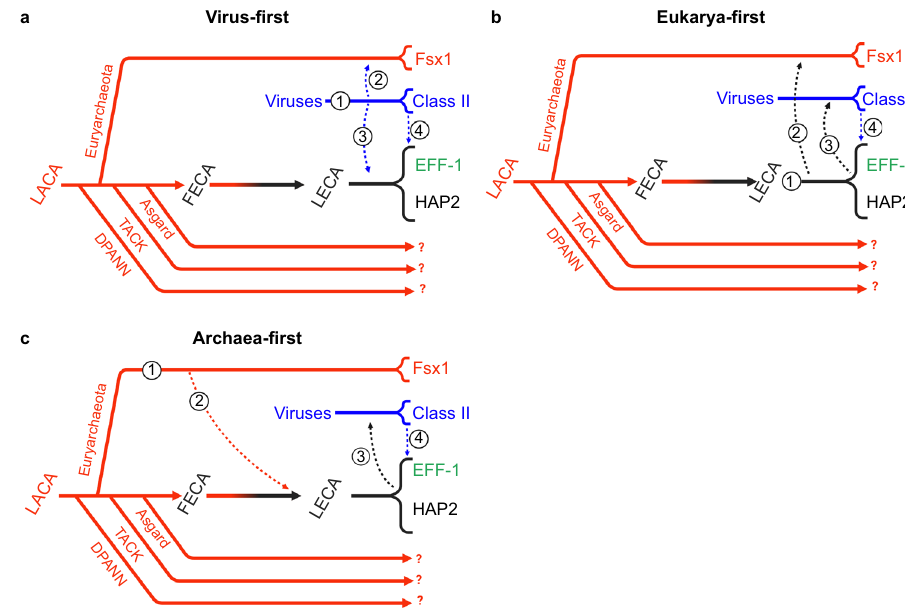
Fig. 9 Possible evolutionary trajectories. a Virus- fi rst. Originating in the virosphere (1), ancestral fusexins were transfered to an ancient eukariotic organism (2) before the eukaryal radiation. Also before the eukaryal radiation, either viral (3) or early eukaryal (not numbered) fusexins were horizontally transferred to Archaea where they became integrated mobile elements. b Eukarya- fi rst. Originating before the eukaryal radiation (1), fusexins were horizontally transferred to Archaea (2) where they became integrated in mobile elements. Eukaryal fusexins were captured by eukaryal viruses (3) leading to extant viral (class II) fusexins. c Archaea- fi rst. Originating in Euryarchaeota (1), fusexins were horizontally transfered (2) and became fi xed during eukaryogenesis and the emergence of meiotic sex. Viral capture of fusexin genes from early eukaryotic cells and further evolution within the virosphere led to extant viral (class II) fusexins (3). Common to all models, viral fusexin genes were captured by different eukaryotic lineages (4), leading to phlebovirus-like integrated fusogens and EFF-1 somatic fusogens 48,67 . Solid lines represent evolutionary trajectories of Archaea (red), viruses (blue), Eukarya (black), and eukaryogenesis (red to black gradient). Dashed arrows represent HGT events. Question marks denote uncertainty regarding the presence of fsx1 -related genes in the respective lineages. LACA Last Archaeal Common